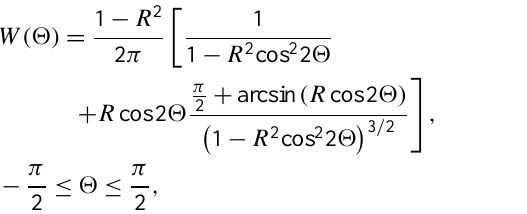
Figure 12. Dependencies of T 1 and T 2 on R for oblate and prolate